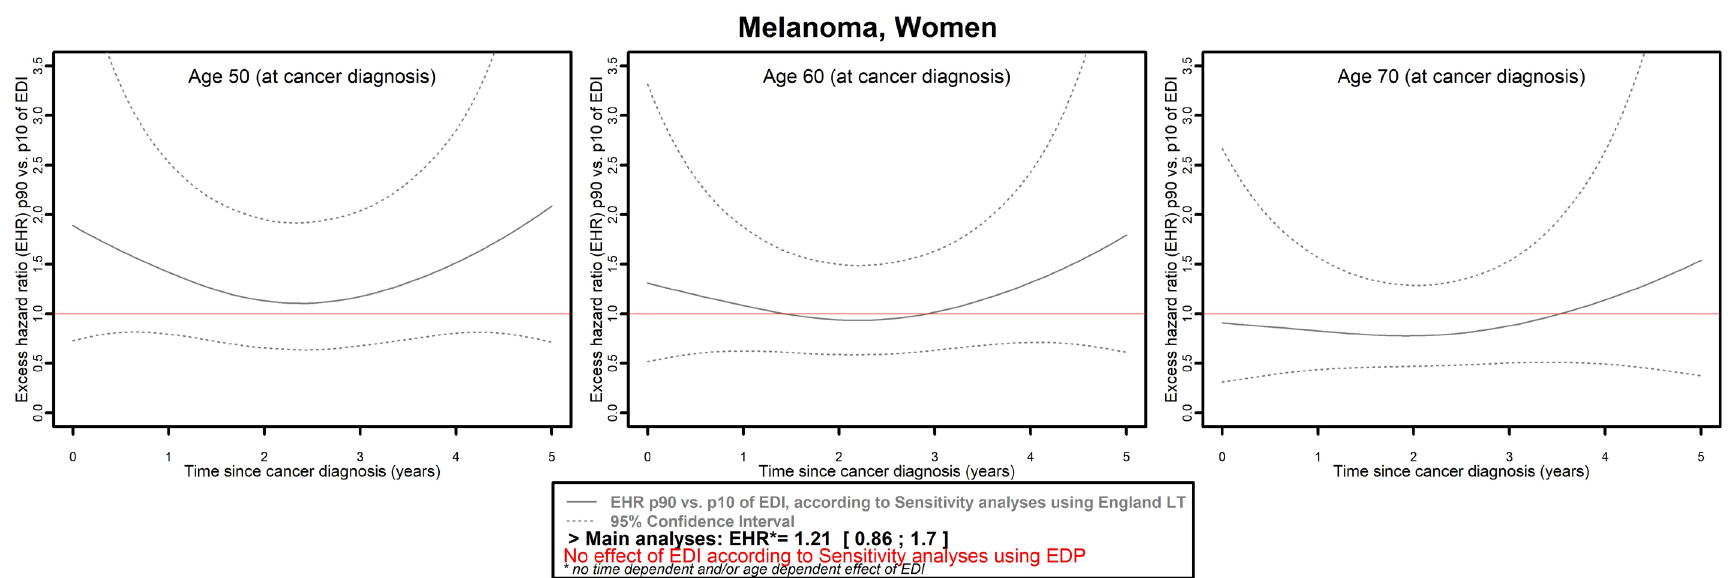
Figure 4. Excess mortality hazard ratio (EHR) between the 90th and the 10th percentile of the national distribution of EDI, as a function of the time since cancer diagnosis according to main and sensitivity analyses, for cancer sites for which the effect of EDI was different according to the analysis (i.e., different models selected in the three analyses) and time-dependent. For melanoma in women, the effect of EDI on excess mortality was also age-dependent in the sensitivity analysis using English life tables, therefore results are presented for 3 values of age corresponding to the 25th, 50th and 75th percentiles of the age distribution in the studied female population with melanoma. EDI: European Deprivation Index; EDP: French permanent demographic sample [Echantillon Démographique Permanent]; EHR: excess mortality hazard ratio; LT: life tables; p90, p10: 90th and 10th percentile of the national distribution of EDI.